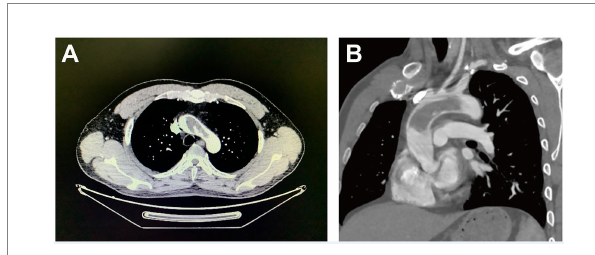
FIGURE 1 Computer tomography images (cross-section for Panel A and longitudinal-section for Panel B ) of a giant floating thrombus from the ascending aorta to the arch.